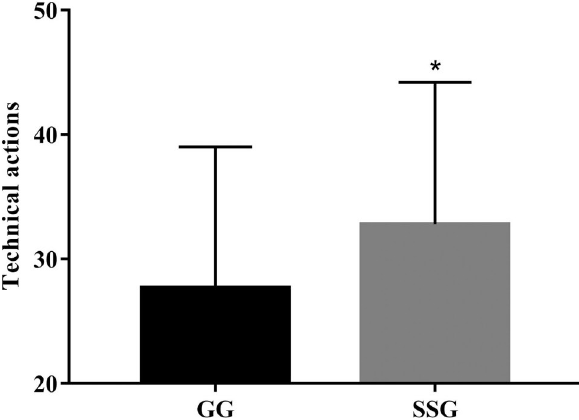
Figure 4 - Comparison of the number of technical actions in the two game situations. Data presented in mean ± standard deviation for all technical actions grouped. * - significant difference for GG.